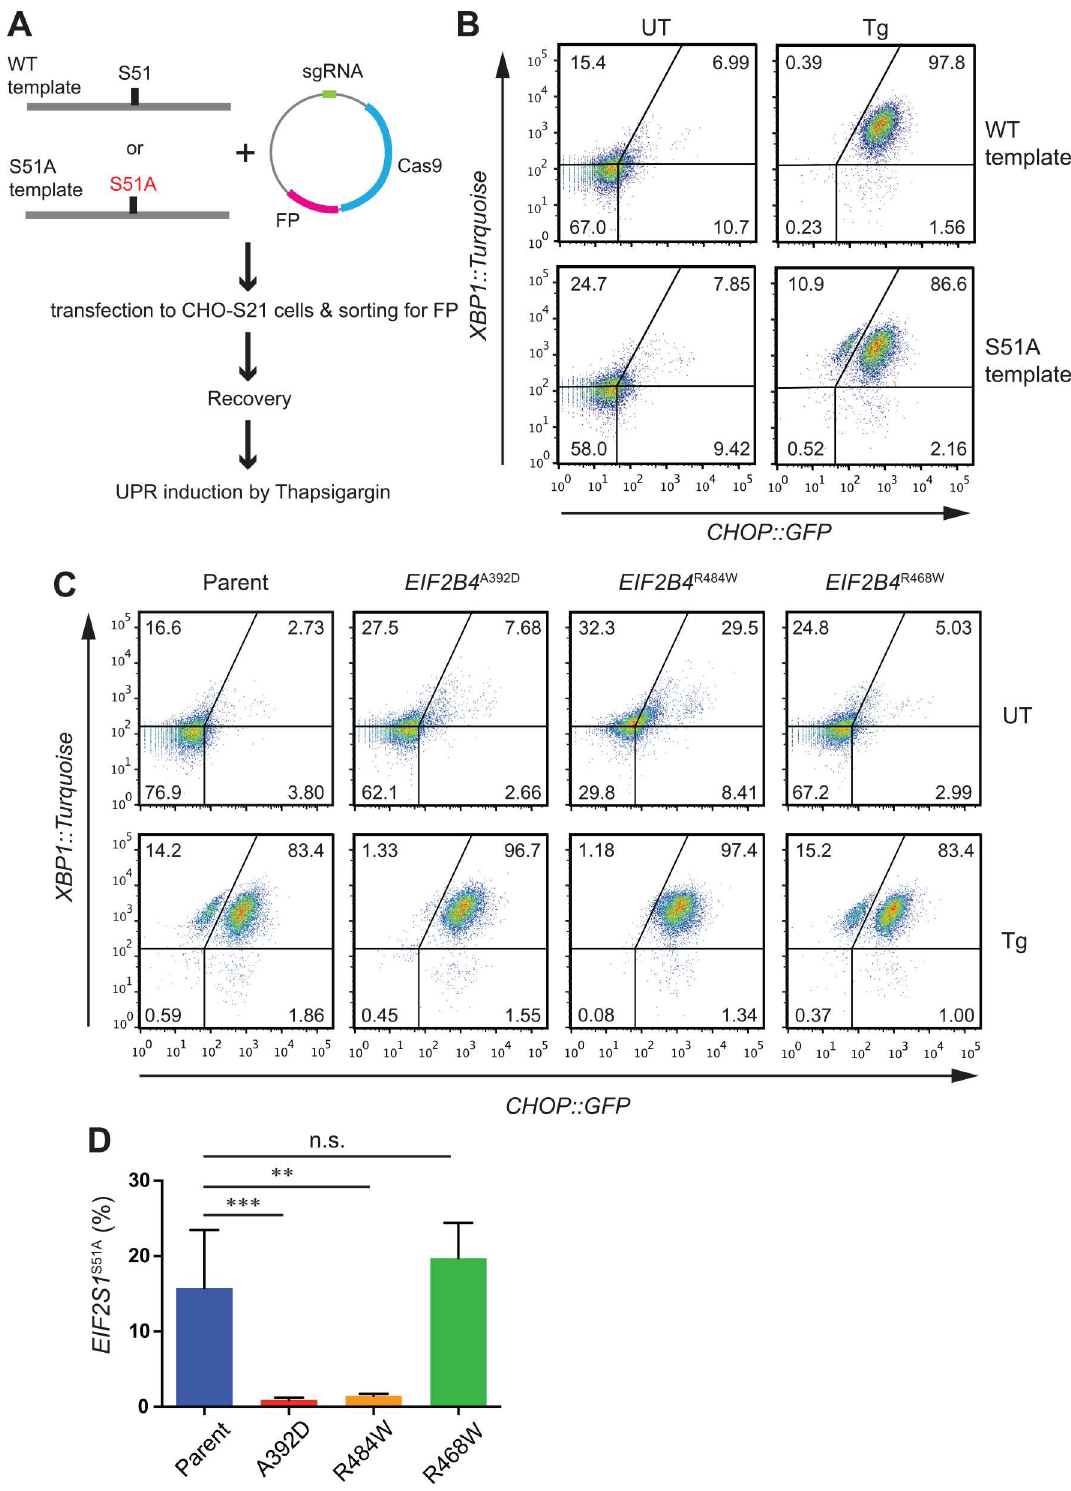
Fig 3. Severe VWM mutant cells are unable to tolerate a second EIF2S1 S51A mutation. (A) Experimental design for tracking EIF2S1 S51A mutant cells. A fluorescent-taggedsgRNA/Cas9 plasmid targeting EIF2S1 was co-transfected alongsidewild type (WT) or EIF2S1 S51A (Mut) templates into CHO-S21 dual reporter cells. FollowingFACS selection for the transfected cells they were treated with 250 nM thapsigargin (Tg) for 24 hours and reporter expression was analyzed.